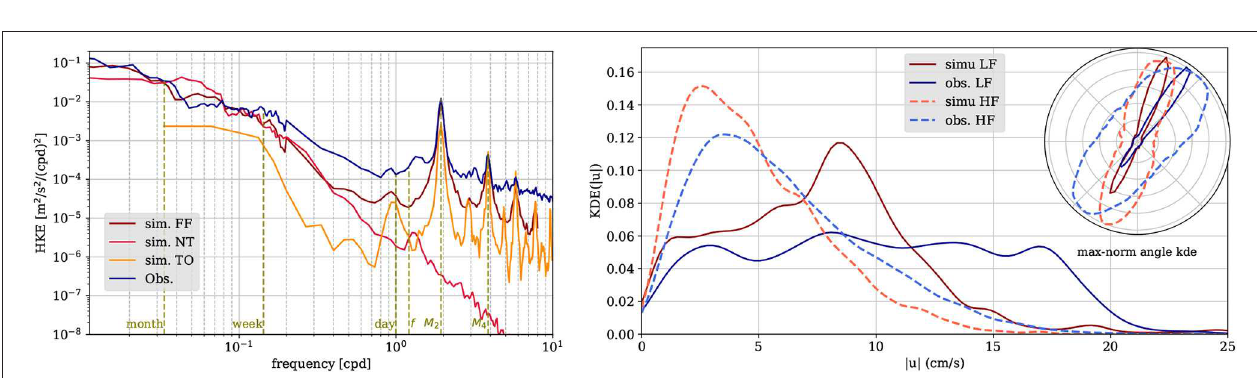
FIGURE 8 | Kinetic Energy spectra (left) and Kernel Density Estimates (right) at a mooring from Graviluck experiment (M1, 1,870 m). The different curves in red to orange shades correspond to different numerical simulations (FF, Full Forcing; NT, No Tidal forcing; TO, Tidal forcing Only). In the right panel, Kernel density estimates are computed on low-pass and high-pass filtered time series (“LF” and “HF,”